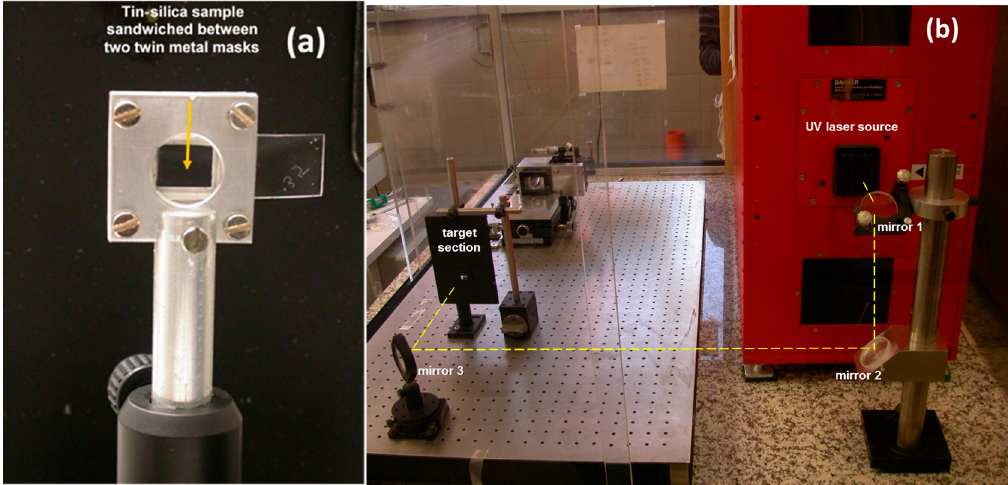
Figure 3. ( a ) The SnO 2 –SiO 2 waveguide sandwiched between two twin metal masks. ( b ) The experimental apparatus setup used for the UV irradiation of the SnO 2 –SiO 2